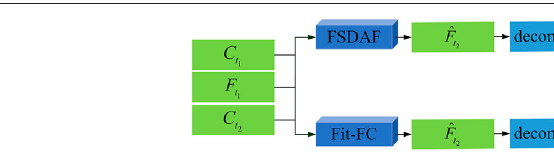
FIGURE 1 | Flowchart of the proposed combination method.